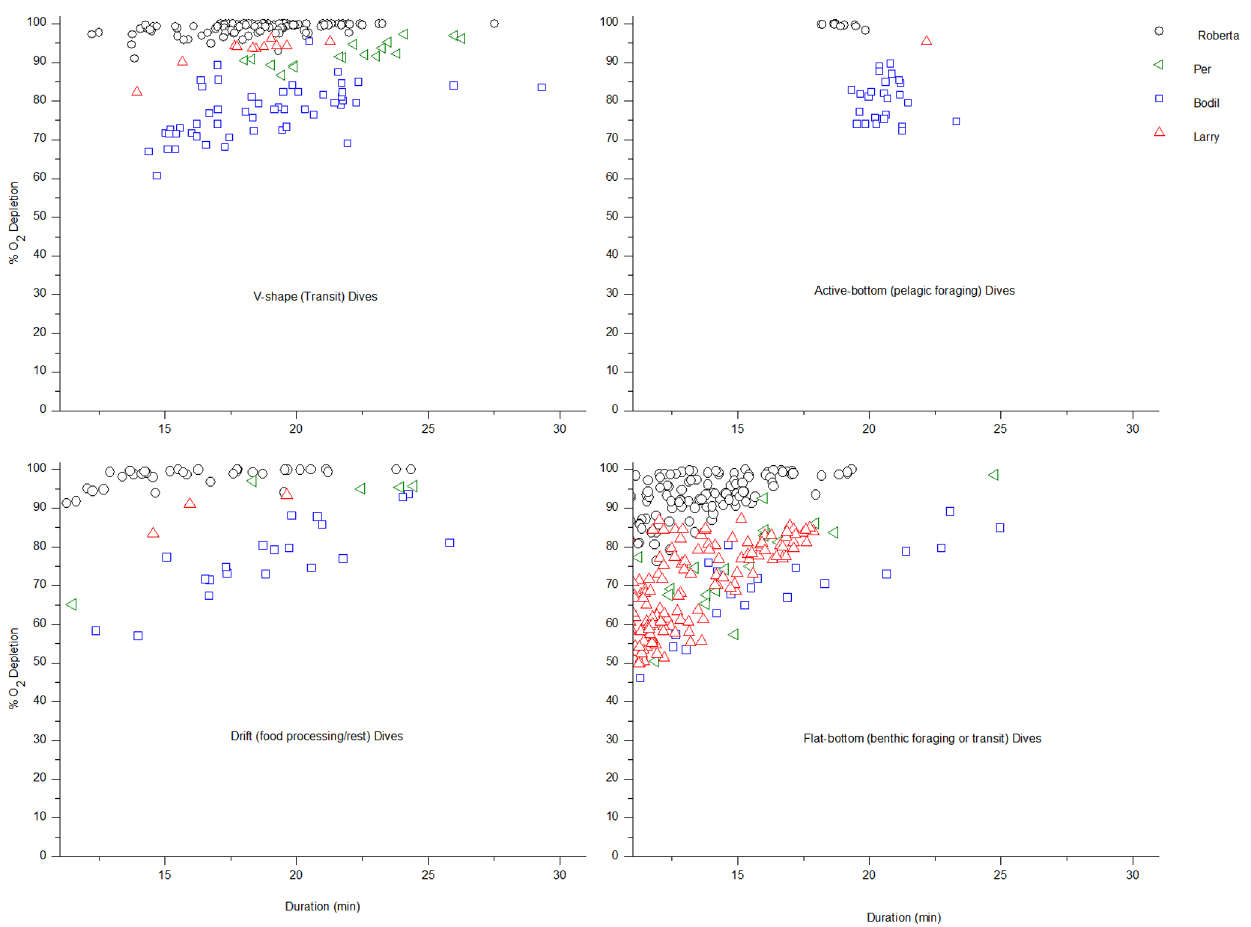
Figure 1. Dive duration and % blood O 2 depletion according to dive type in diving elephant seals. Dive type panels of % blood O 2 depletion vs . dive duration (min) for dives . 10 min of seals with electrodes in the hepatic sinus (n=4 seals), symbol/color coded per individual seal. Dive types were classified according to the following: v-shape (transit), active-bottom (pelagic foraging), drift (food processing or rest), and flat- bottom (benthic foraging or transit).